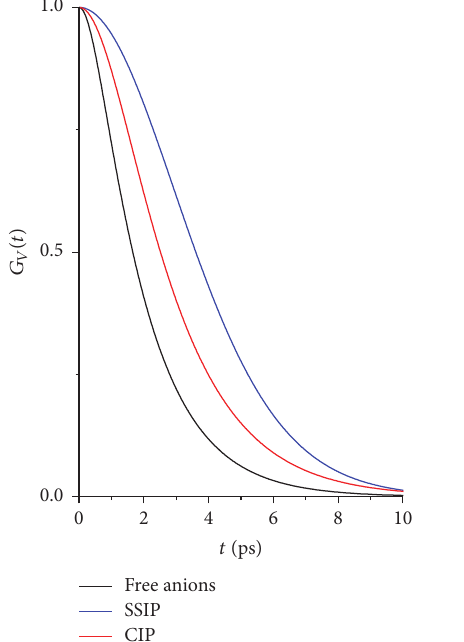
Figure 8: Representative time-correlation functions of dephasing of ClO 4− anion in free state, SSIP, and CIP in the DMSO solution containing 0.1 mole fractions of LiClO 4